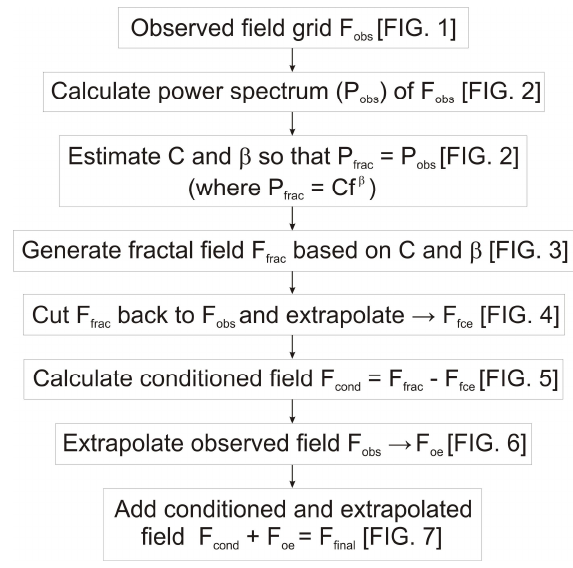
Fig. 8. Flow chart summarizing the steps required for fractal grid extrapolation. Where quantities have been plotted, the appropriate figure number is indicated. The expressions used for different quantities (e.g., F obs ) are not used in the text but used here for brevity.